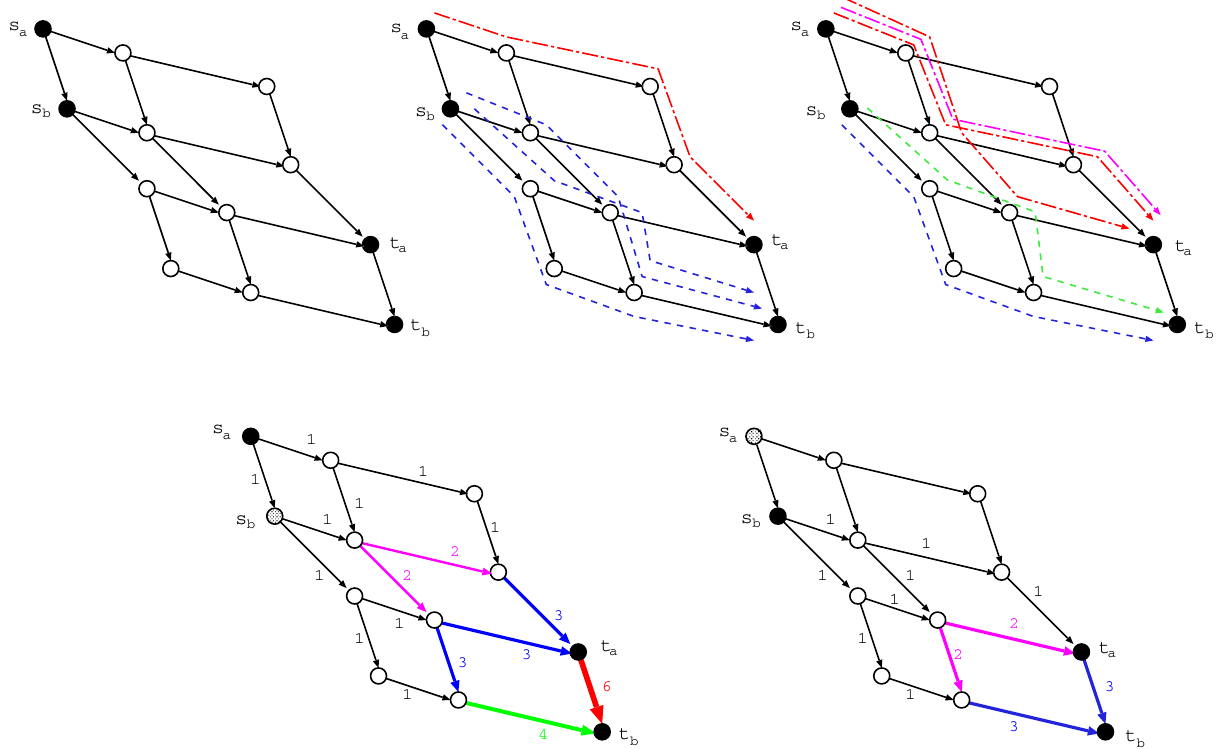
Figure 1. Example of six combinations of two non-intersecting paths from s a to t a and from s b to t b . (Top-Left) A planar directed graph with pairs of k = 2 boundary vertices. (Top-Middle) One s a - t a path colored by red and its corresponding three s b - t b paths colored by blue. (Top-Right) Two s b - t b paths colored by blue or green and their corresponding s a - t a paths colored by red or magenta. Note that any two paths from s a to t b and from s b to t a are intersected. (Bottom-Left) From s a to t a or t b , (Bottom-Right) from s b to t a or t b , the numbers of paths calculated by token-passing in the “Methods” section. 1, 2, 3, 4, 6 are the numbers of reached tokens at the tips of arrows. They represent the numbers of paths which go through each edge from s a or s b .